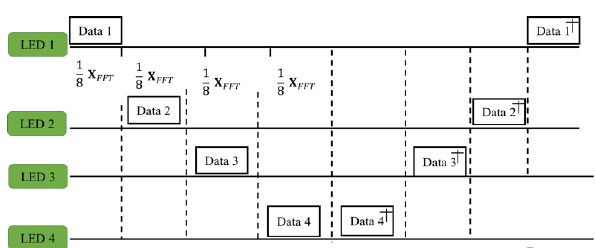
Figure 3. OFDM signal simulation.